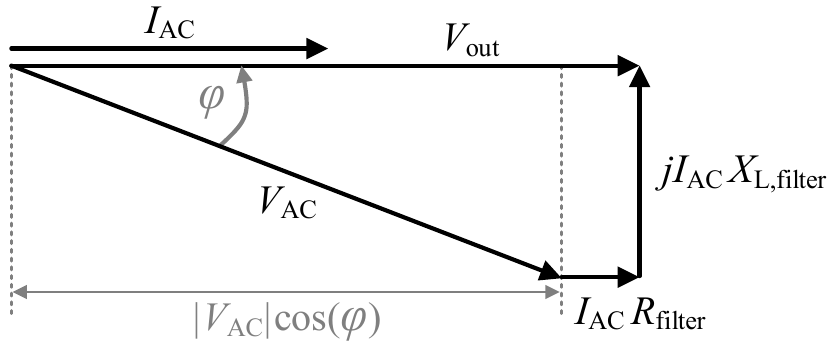
Figure 5. Vector diagram of controlled current I AC relative to converter voltage V out and grid voltage V AC when operating converter in grid-feeding mode without capacitor voltage